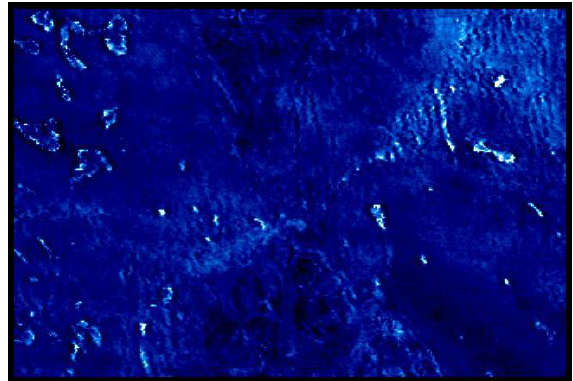
Figure 5. Derived height-to-width ratio for the study area. Dark areas indicate lower values and lighter areas indicate higher values for the derived height-to-width ratio. Derived height-to-width ratios ranged from -0.18 to 0.7. To support better visualisation of the results, outlying values have been replaced with ceiling values of 0.3 and floor values of -0.1 respectively and the image in Figure 5 has had brightness values scaled within this range. Higher height-to-width ratios appear broadly associated with the Cooper Creek and around the edges of dried salt lakes.